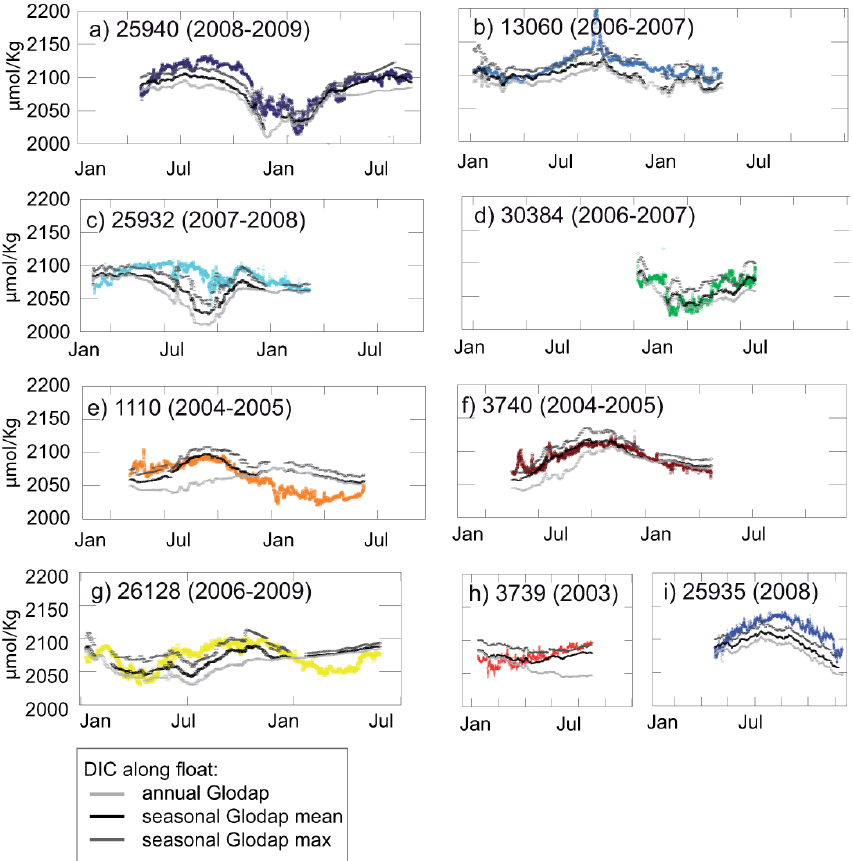
Fig. 10. DIC along CARIOCA drifters trajectories; DIC deduced from the p CO 2 sampled by the drifters (colored lines) is compared to the “annual Glodap DIC” and two estimates of the “seasonal Glodap DIC” along the drifters location. The “annual Glodap DIC” (light grey) shows the large-scale gradients of surface DIC in Glodap in a 5 ◦ by 5 ◦ box centered on the drifter location. The two “seasonal Glodap DIC” estimates were computed by averaging the vertical profile of Glodap DIC over monthly mixed layer depths. The “seasonal Glodap DIC mean” and “seasonal Glodap DIC max”, respectively, correspond to the mean and maximum values obtained in each 5 ◦ by 5 ◦ box centered on the drifters trajectories (see Sect. 3.4), which gives an estimation of the seasonal signal on surface DIC